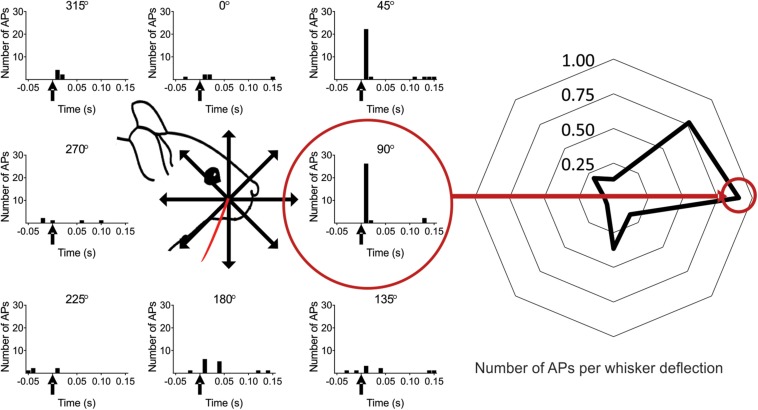
Scheme of the experimental protocol. (Left) The whisker was deflected in eight different directions separated by 45°. In this example the whisker was deflected in total 25 times in each of the eight directions (five deflections, five complete turns). The whisker deflection time is at time zero (marked with an arrow in the PSTH). The red circle shows the preferred direction (PD), defined as the direction in which the recorded neuron responded with on average the most spikes per whisker deflection (calculated in a 100 ms time window) (0° is here defined as the straight upward deflection angle. Note: in subsequent figures the preferred direction is defined as zero degrees, unless stated otherwise). (Right) The data from the left panel plotted as the average number of spikes per whisker deflection (WD) for each angle [100 ms time window, from angle 0° (angle vertical up) to 315°]: 0.13, 0.77, 0.90, 0.17, 0.37, 0.07, 0.07, 0.20 spikes per WD.